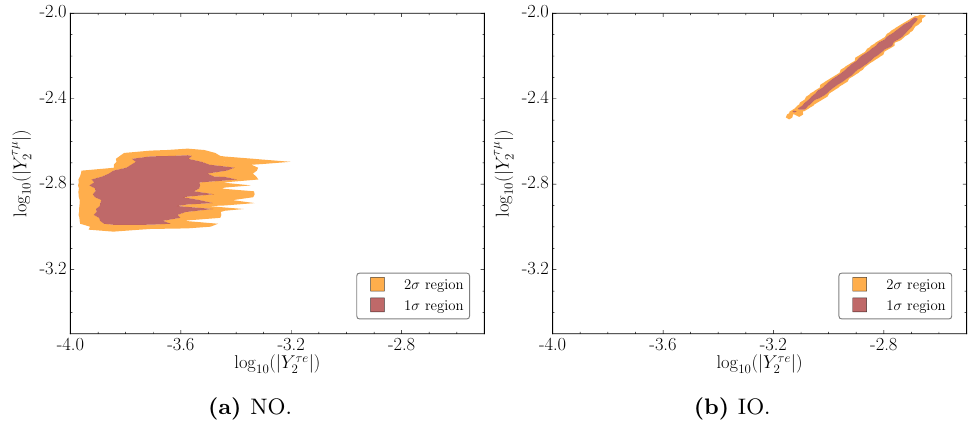
Figure 7. Allowed regions of the Yukawa couplings Y (cid:28)e